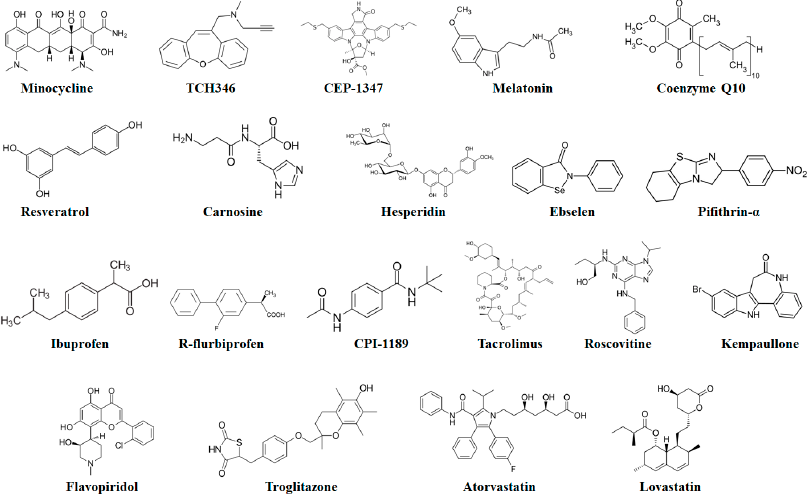
Figure 8. Chemical structures of potential antiapoptotic drugs that might be useful in the treatment of neurodegenerative diseases.